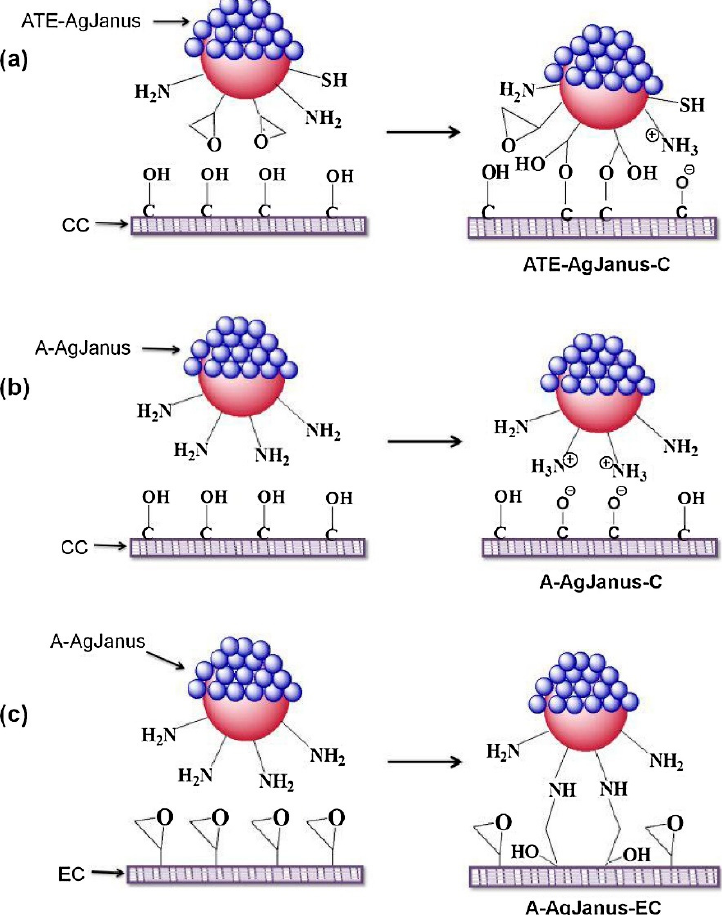
Figure 12. Silver-silicon dioxide Janus nanoparticles with distinct functional groups, such as amine, thiol, and epoxy synthesized via the Pickering emulsion method. ( a ) Mechanistic attachment of amine-thiol-epoxy functional ATE-silver (Ag) Janus on cotton fabric, ( b ) amine functionalized silver Janus interacts with cotton fabric via electrostatic attraction and ( c ) attachment of amine functionalized silver Janus on epoxy functionalized cotton fabric. Reproduced with permission from [122], ©Elsevier (2018).